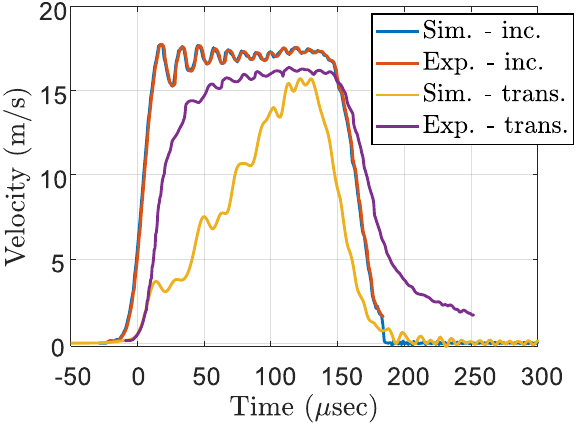
Figure 3. T est comparison with numerical calcs. using quasitatic model for rigid